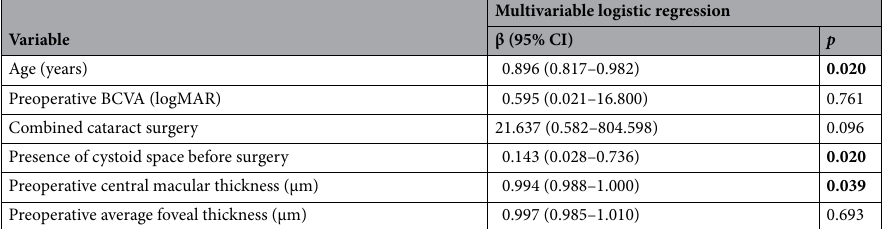
Table 4. Multivariate logistic regression analysis of nasal inner nuclear layer thickening in epiretinal membrane patients after the surgery. BCVA best corrected visual acuity, logMAR logarithm of the minimum angle of resolution. Significant values are in